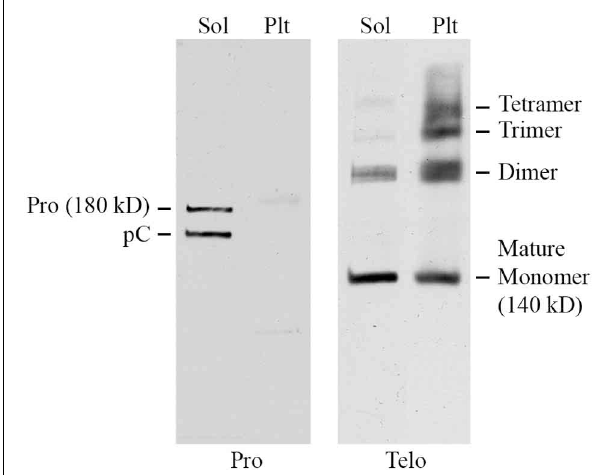
FIGURE 2 | Specificity of Pro and Telo by Western Blotting of tissue extracts. A soluble tissue extract of shaved mouse skin was prepared using detergent-free neutral buffer as previously described for lung tissue (Lee et al., 2014). Following centrifugation, the pellet was re-extracted by boiling for 3min in SDS-PAGE sample buffer. Aliquots of the soluble extract (Sol) and the pellet extract (Plt) representing equal amounts of tissue were then resolved by SDS-PAGE and Western blotted using Pro and Telo as indicated. The identity of the various forms of collagen I recognized by these antibodies is described in the text and indicated on this figure.